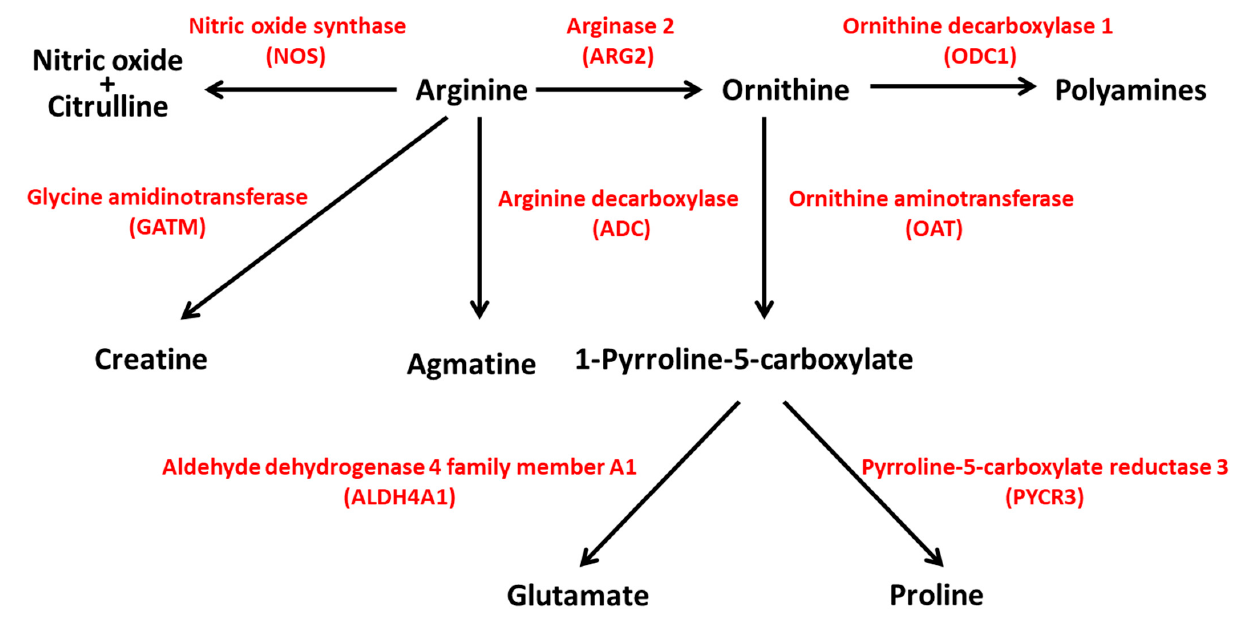
Figure 4. ARG2 activity is central to different pathways in human metabolism. ARG2 is involved in the biosynthesis of polyamines, glutamate, proline, creatine, agmatine, nitric oxide and citrulline. NOS, nitric oxide synthase; ARG2, arginase 2; ODC1, ornithine decarboxylase 1; GATM, glycine amidinotransferase; ADC, arginine decarboxylase; OAT, ornithine aminotransferase; ALDH4A1, aldehyde dehydrogenase 4 family member A1; PYCR3, pyrroline-5-carboxylate reductase